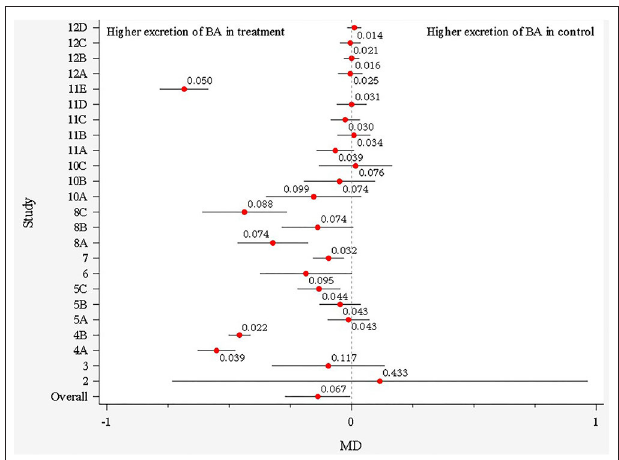
FIGURE 2 | Forest plot showing the main difference (MD) and its 95% CI for each study before outlier removal. Each study is represented by a number and letters represent different soluble fiber treatments within each study.